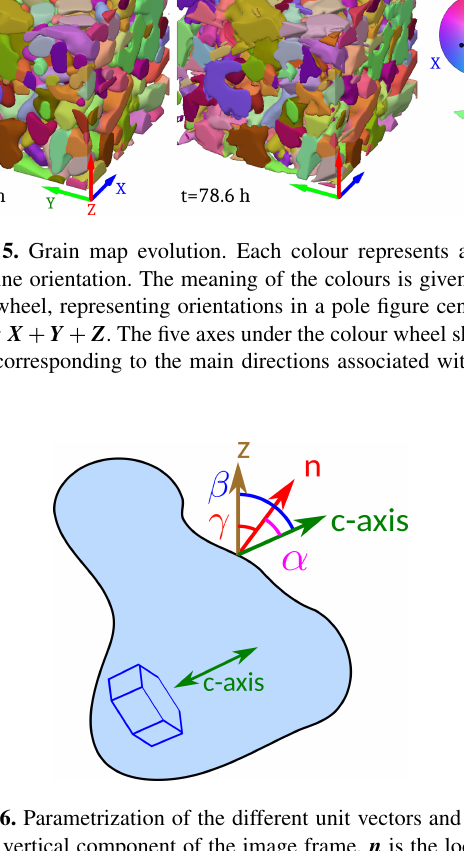
Figure 6. Parametrization of the different unit vectors and angles: z is the vertical component of the image frame, n is the local nor- mal outgoing from the ice and c is a vector with positive vertical component representing the c -axis direction.